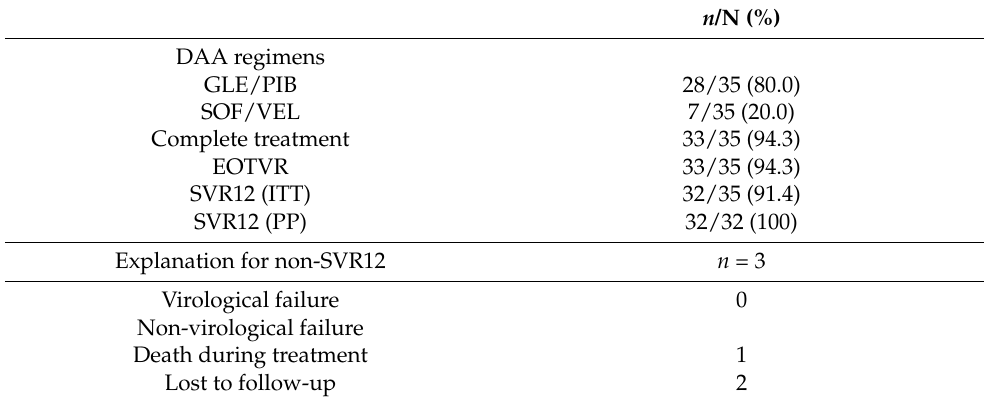
Table 3. Treatment outcomes of 35 patients receiving